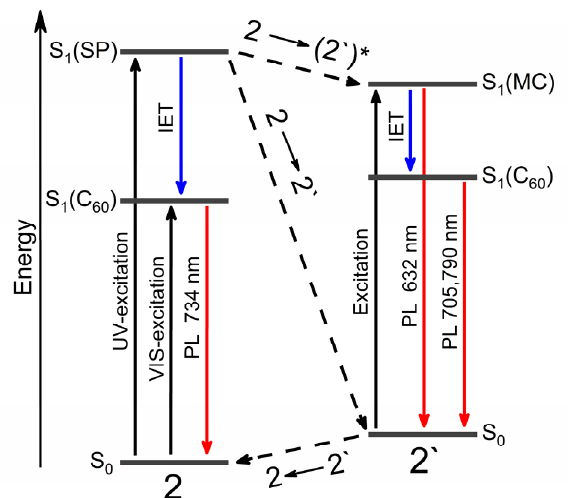
Figure 5. The proposed scheme of photochemical and photophysical processes occurring upon photoirradiation of fulleropyrrolidine. SP, MC and C 60 -spiropyran, merocyanine and fullerene fragments of hybrid molecule 2 or 2 (cid:48) , IET–intramolecular energy transfer, ( 2 (cid:48) )* – compound 2 in electronically excited state. The diagram does not show the processes of internal conversion and intercombination